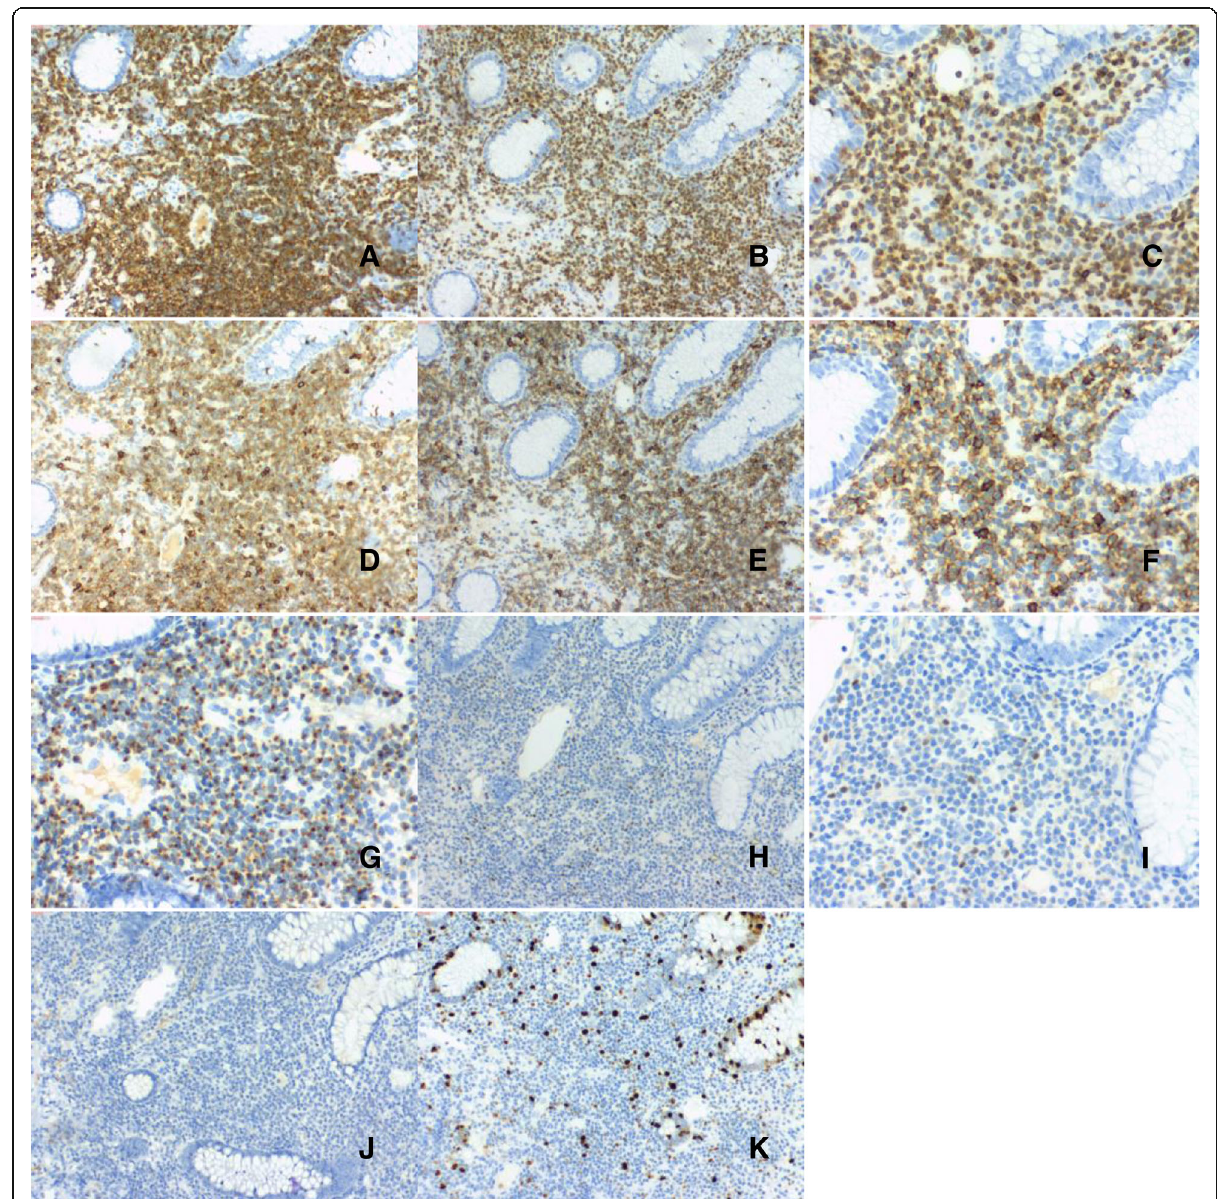
Fig. 3 Biopsy specimen from the colon (2017). The lymphocytes express CD2 ( a ), CD3 ( b,c ), CD5(d), CD20 ( e,f ), and TIA-1 ( g ). Staining was negative for PAX5 ( h , i ) and CD56(J). The Ki67 ( k ) proliferative index was